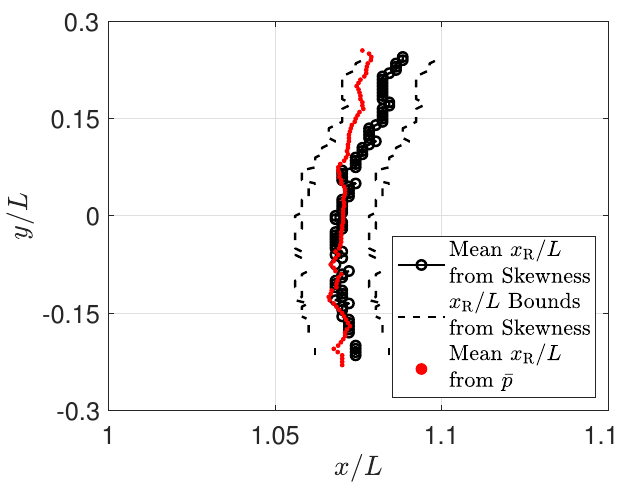
Figure 5. Spanwise skewness and ¯ p reattachment